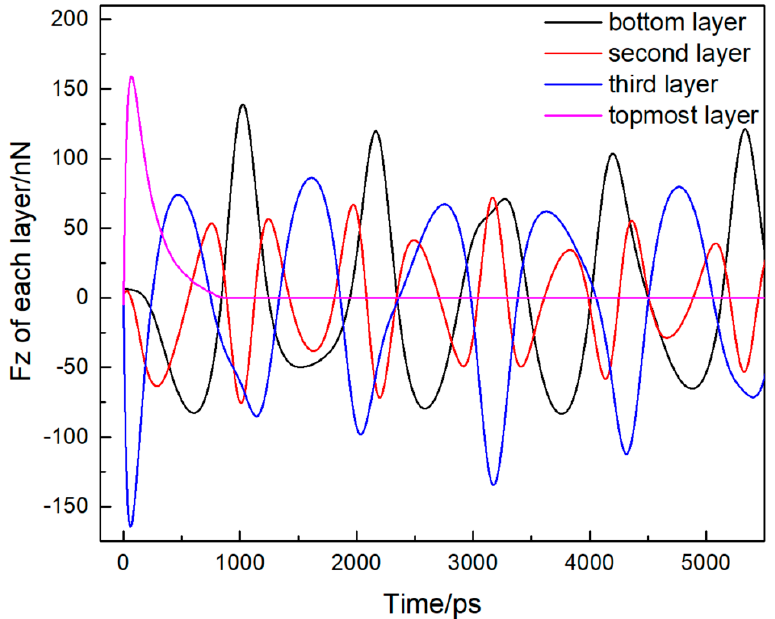
Figure 12. Fz to exfoliate each layer varying with time in the four-layer graphene system, when the vertical upward velocity was 15 Å/ps.